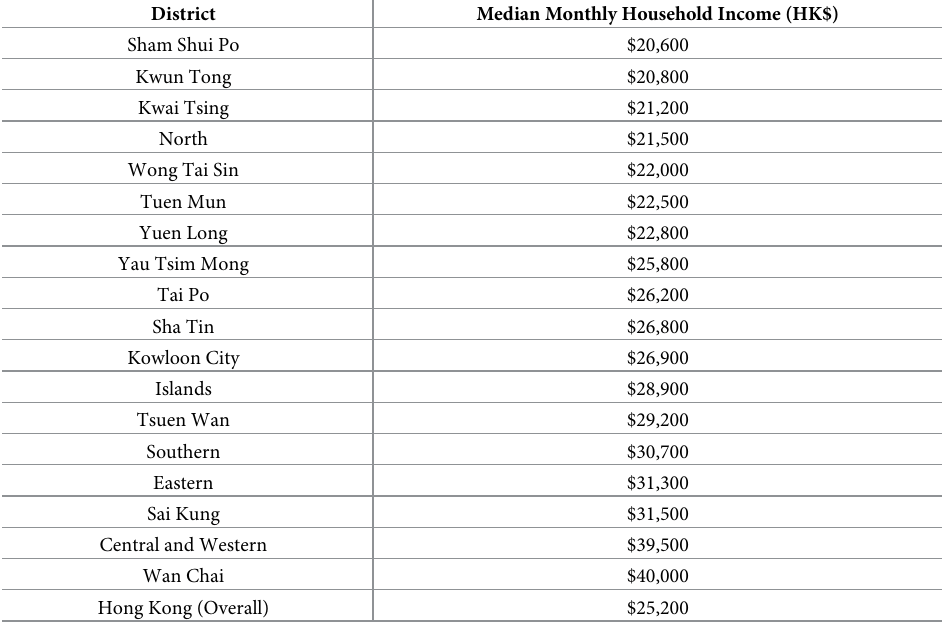
Table 1. Median monthly household income (HK$) by